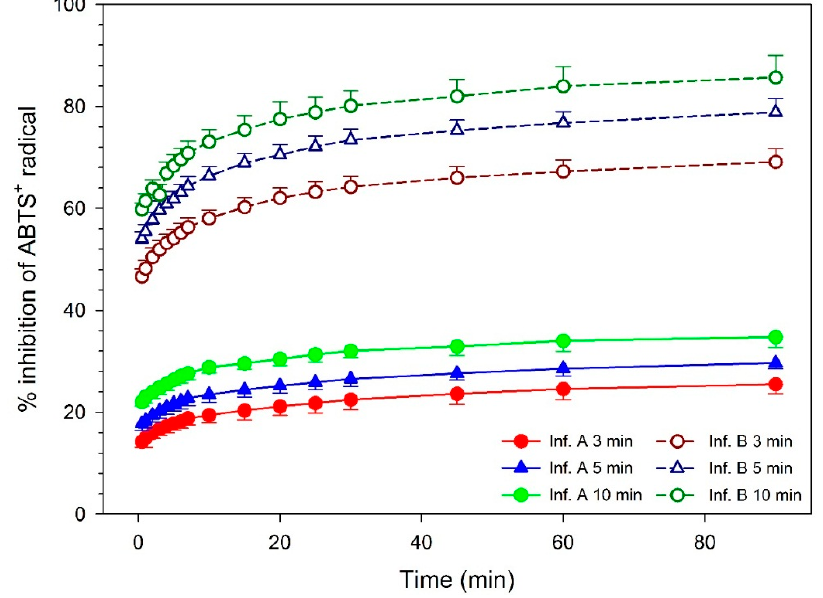
Figure 1. Antioxidant activity of Sideritis hyssopifolia infusions versus time. Antioxidant activity is expressed as inhibition percentage of ABTS •+ radical. Two different infusions (A: 5 × 10 − 5 g/mL; B: 1.5 × 10 − 4 g/mL), and three times of infusion were assayed (3, 5 and 10 min). Data are expressed as mean ± SD (n = 5).